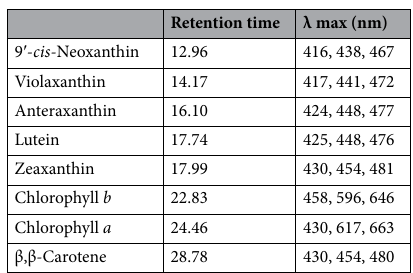
Table 4. List of pigments detected in halophytes ( Salicornia ramosissima ) with average retention times and absorption maxima (λ max).